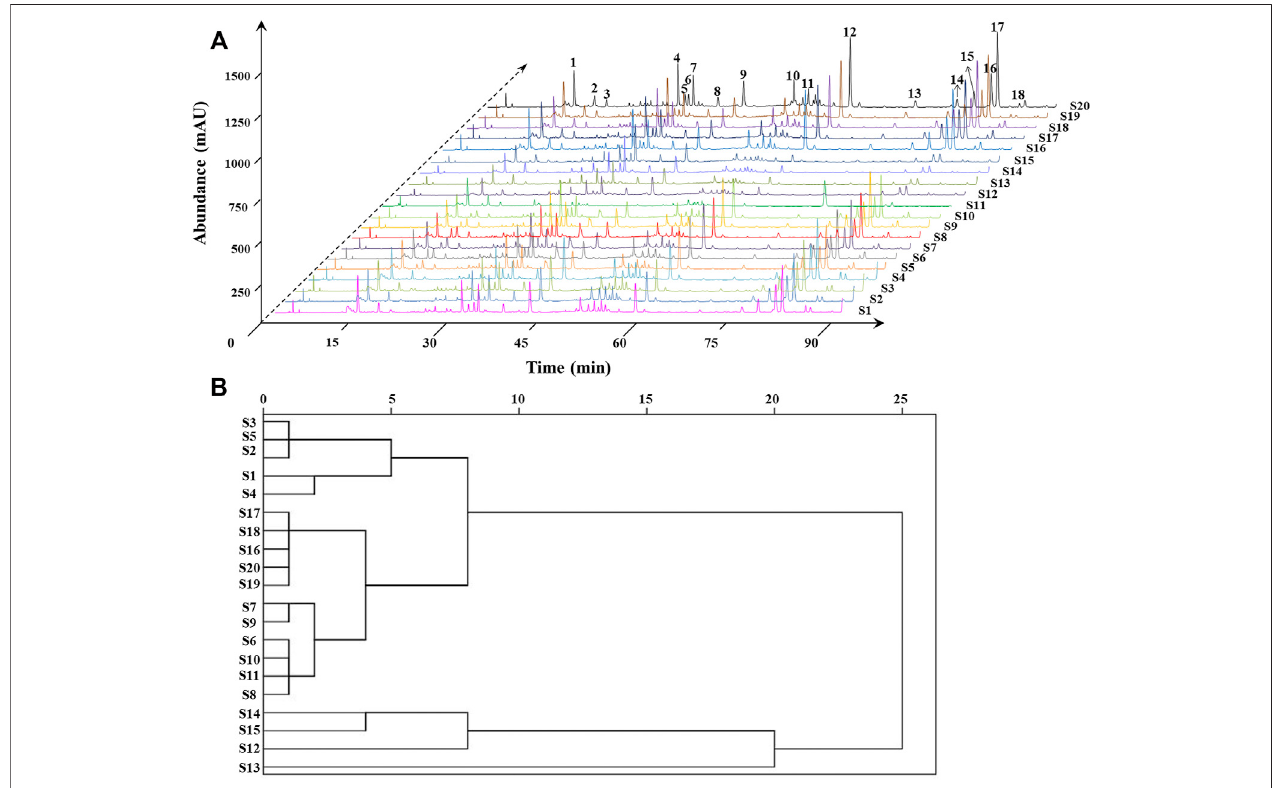
FIGURE 4 | HPLC fi ngerprints and common peaks of 20 batches of ZN samples (A) . Cluster analysis of 20 batches of ZN samples (B) .